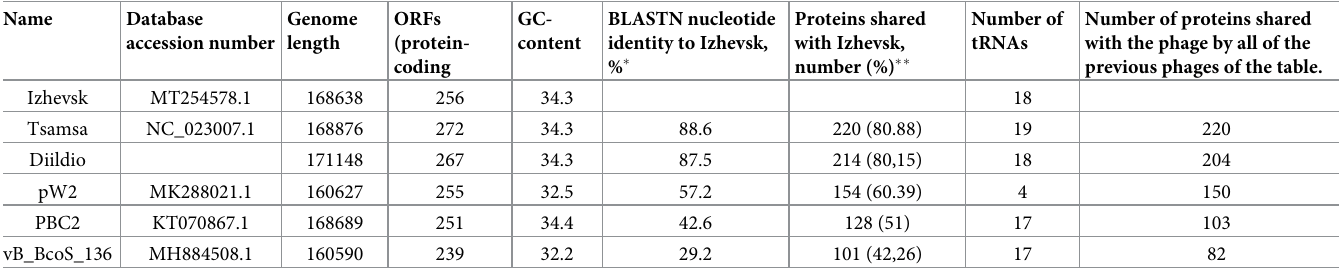
Table 2. The properties of Izhevsk and the most closely related